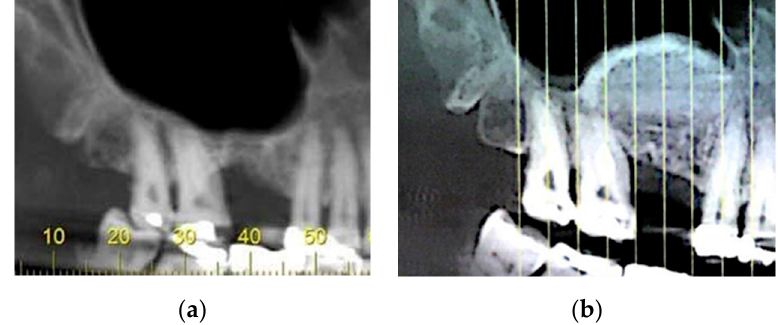
Figure 1. Representative panoramic view of the treated area: ( a ), baseline; and ( b ), after augmentation.